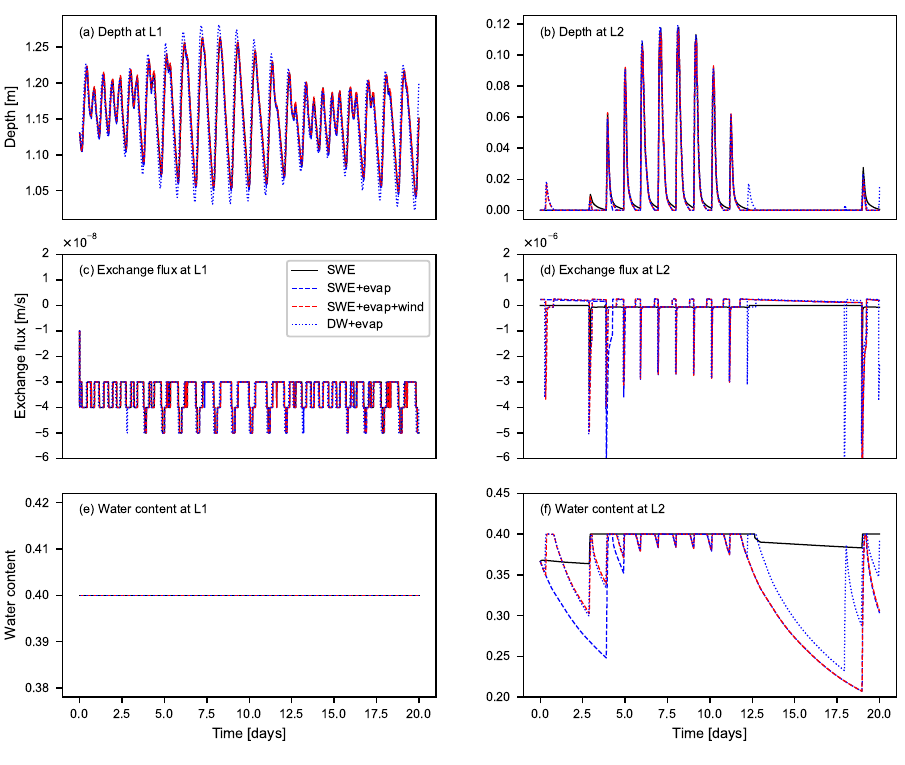
Figure 13. Time-varying depth, surface-subsurface exchange flux (positive upward) and water content of the topmost subsurface cell at monitoring locations L1 and